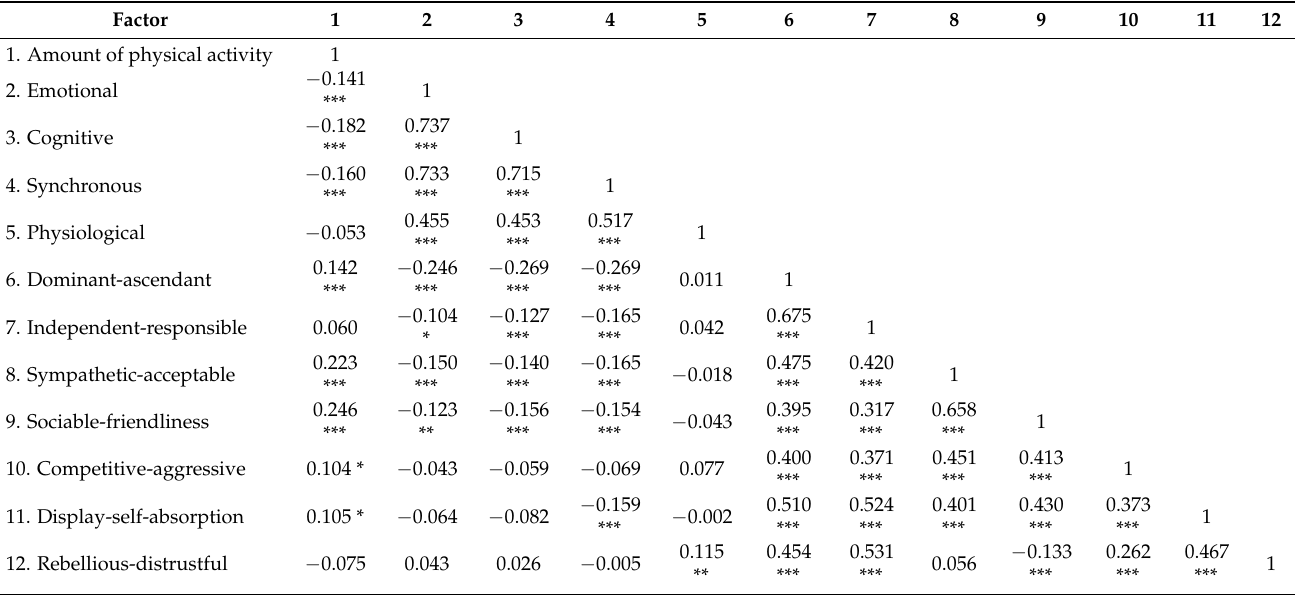
Table 8. Correlation among physical activity, depression, and personal